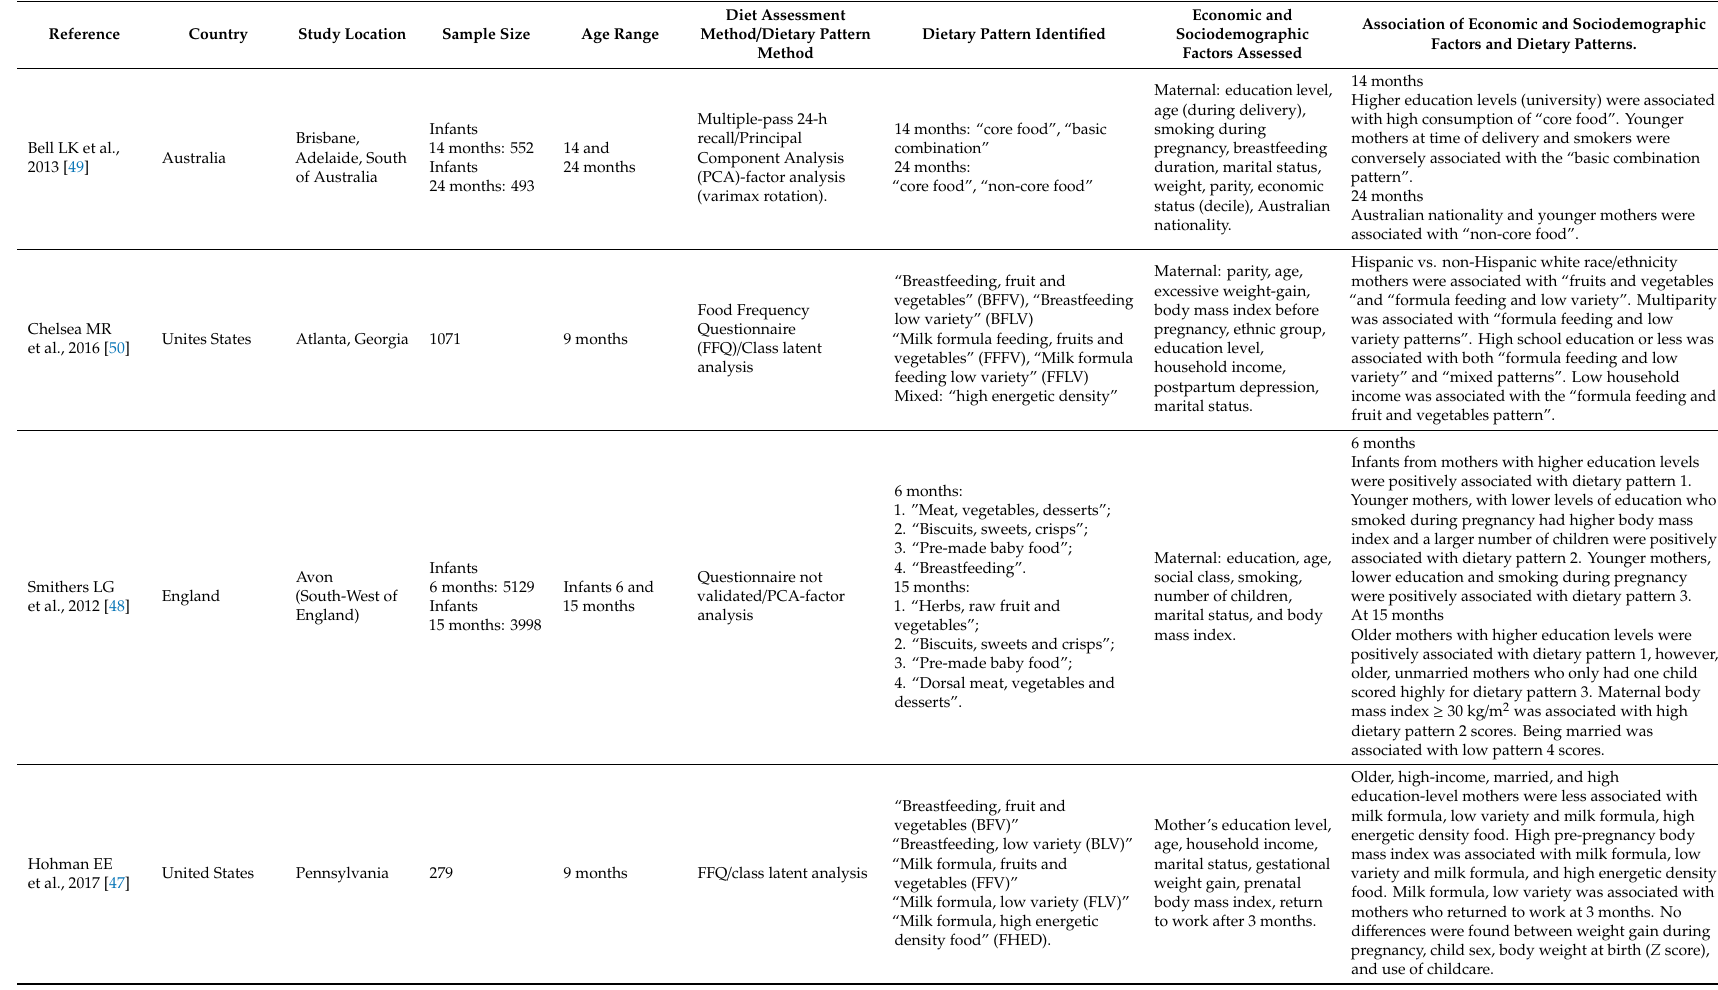
Table 2. Socioeconomic factors and their associations with dietary patterns defined in an “a posteriori” approach in children under 24